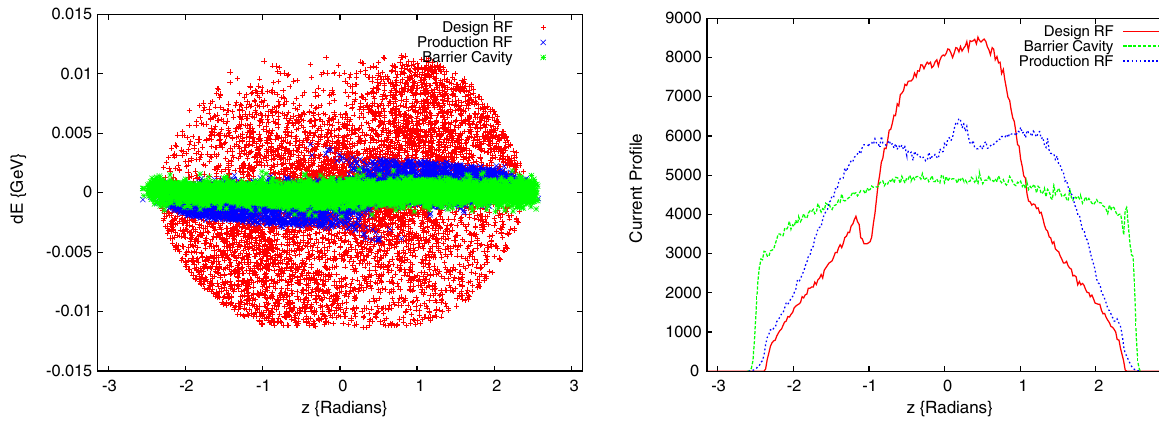
FIG. 4. Results following accumulation at full intensity are shown for three rf bunching scenarios: dual harmonic rf at the SNS design voltages of 40 kV first harmonic and 20 kV second harmonic (red), the barrier cavity waveform shown in Fig. 3 (green), and dual harmonic rf with 4 kVin both harmonics (blue). (Left) Longitudinal phase space distributions and (right) longitudinal current profiles for the three